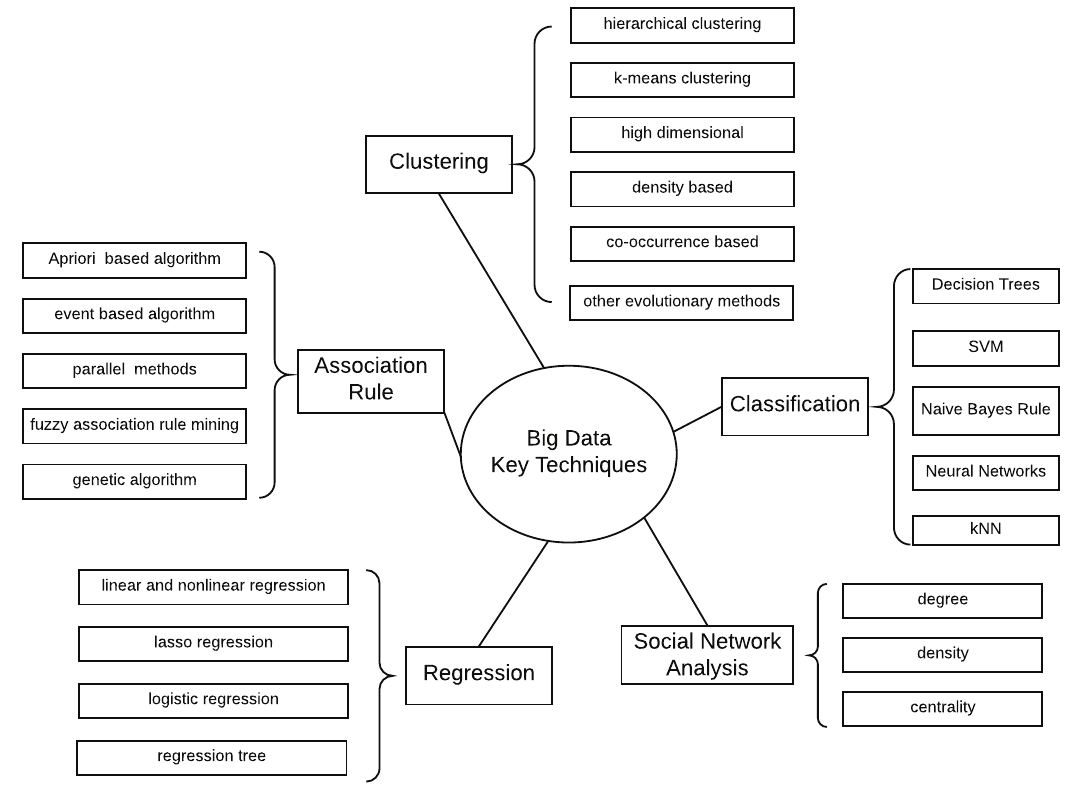
Figure 3. The structure of big data key